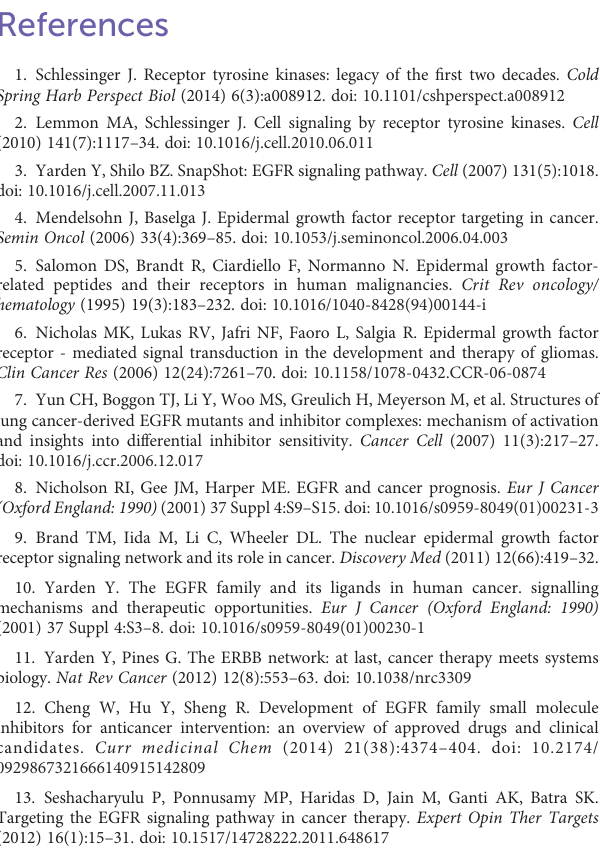
SUPPLEMENTARY FIGURE 1 NIFTP case showing protein expression that is stronger in areas under the capsule compared to the core nodule where a weak cytoplasmic stain is detected indicating loss of the protein. Intensity of EGFR expression negatively correlates with expression of miR-146b-5p detected by in situ hybridization (purple